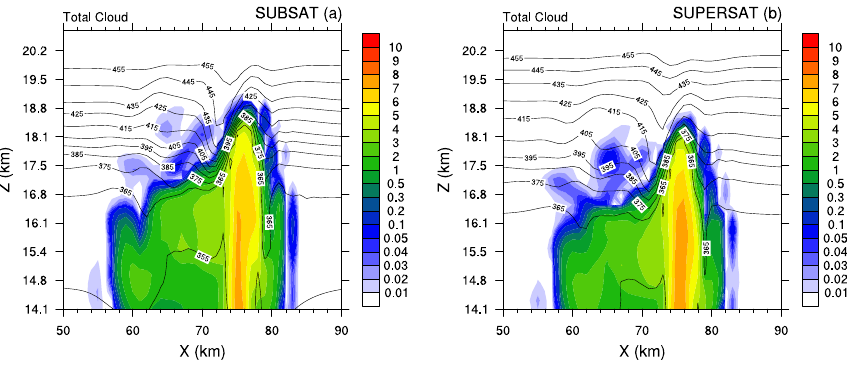
Fig. 2. Vertical cross-sections of total cloud mixing ratio(g kg − 1 ) for (a) SUBSAT and (b) SUPERSAT, taken along y = 80km at t = 40min. They show the TTL (and lower stratosphere) region only. Note that the levels of neutral buoyancy heights are 16.5 and 16.0km for the SUBSAT and SUPERSAT cases,